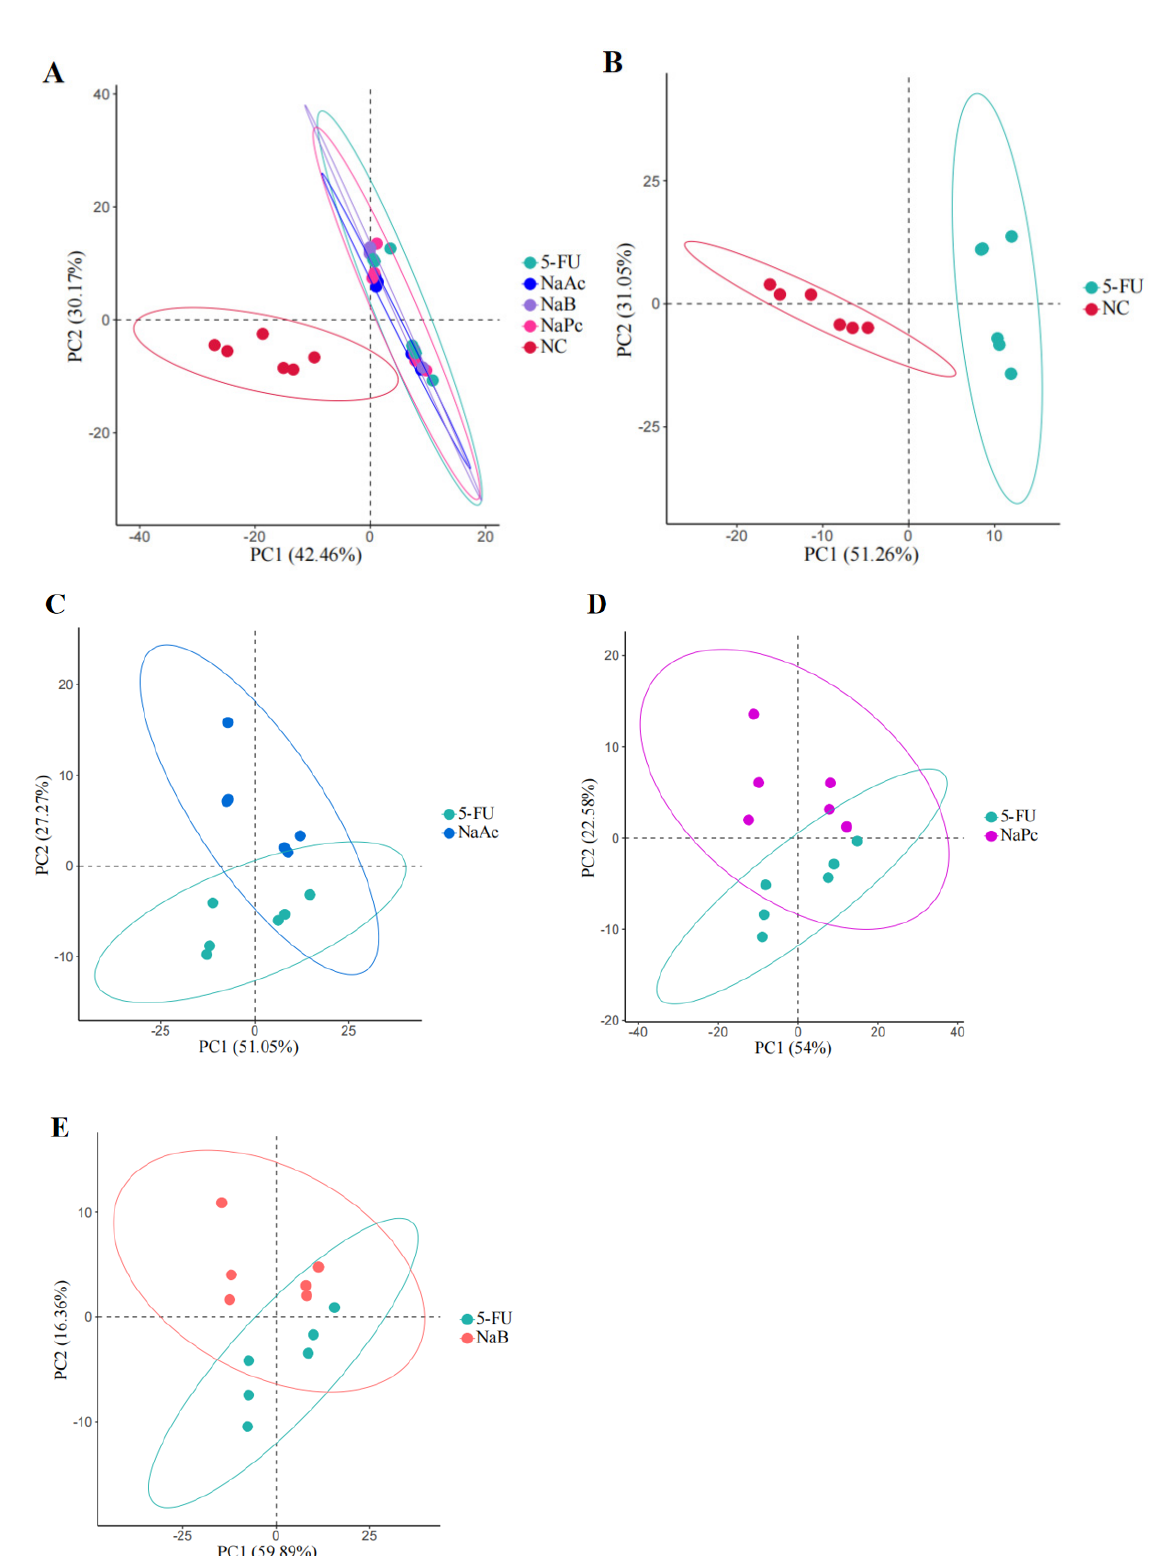
Figure 5. PCA score plot in the positive ion mode analysis for the effects of SCFAs on cellular metabolites ( n = 6/ group). ( A ): PCA score plot analysis in all groups; ( B ): PCA score plot analysis for the NC and 5 − FU group; ( C ): PCA score plot analysis for the NaAc and 5 − FU group; ( D ): PCA score plot analysis for the NaPc and 5 − FU group; and ( E ): PCA score plot analysis for the NaB and 5 − FU group.